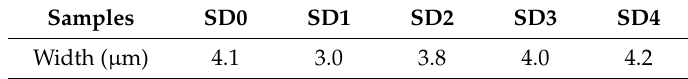
Table 3. The average width of the crack between diamond and matrix of impregnated samples.